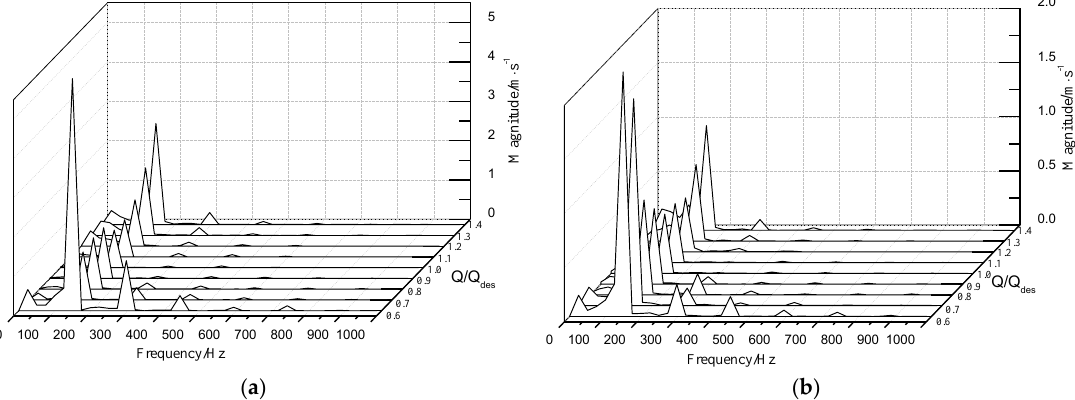
Figure 24. Frequency distribution of the velocity under different flow conditions: ( a ) X direction; ( b )